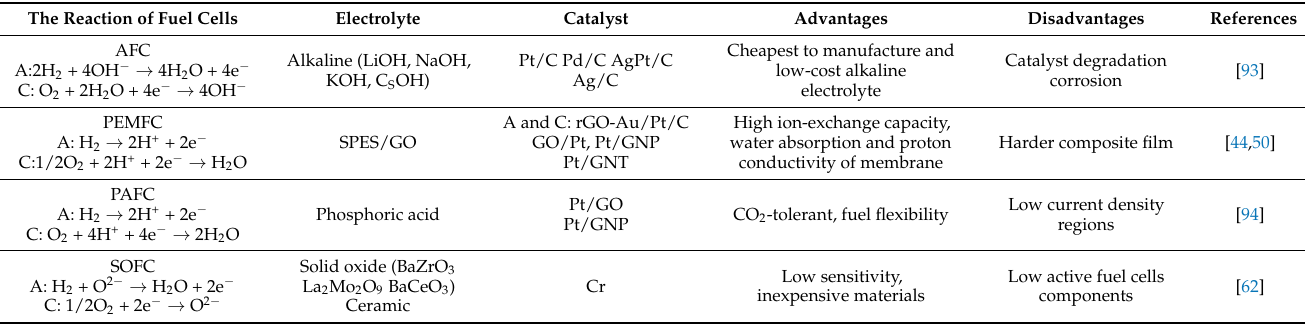
Table 2. Overview of different types of fuel